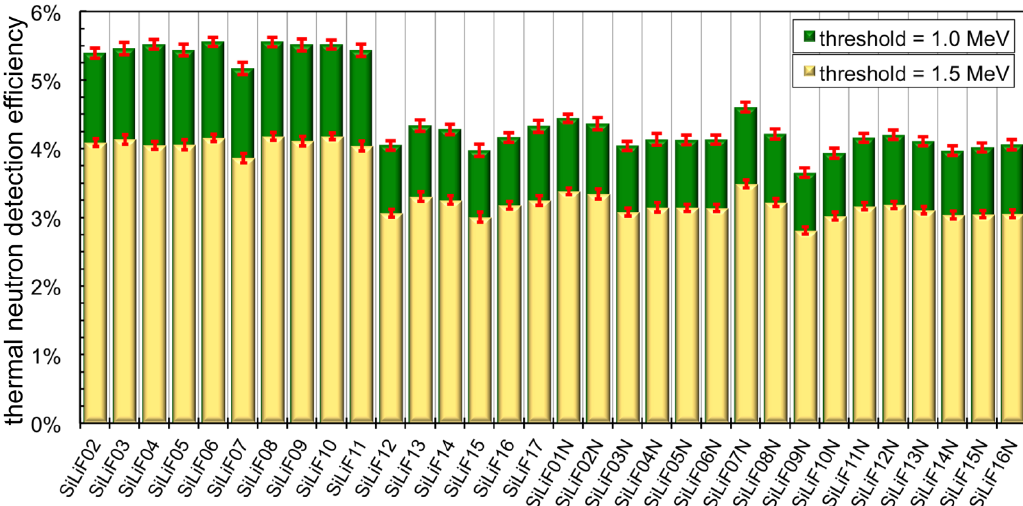
Figure 17. The intrinsic detection efficiency measured for the 32 SiLiF detectors in the inside configuration, with nominal energy thresholds of 1 and 1.5 MeV.